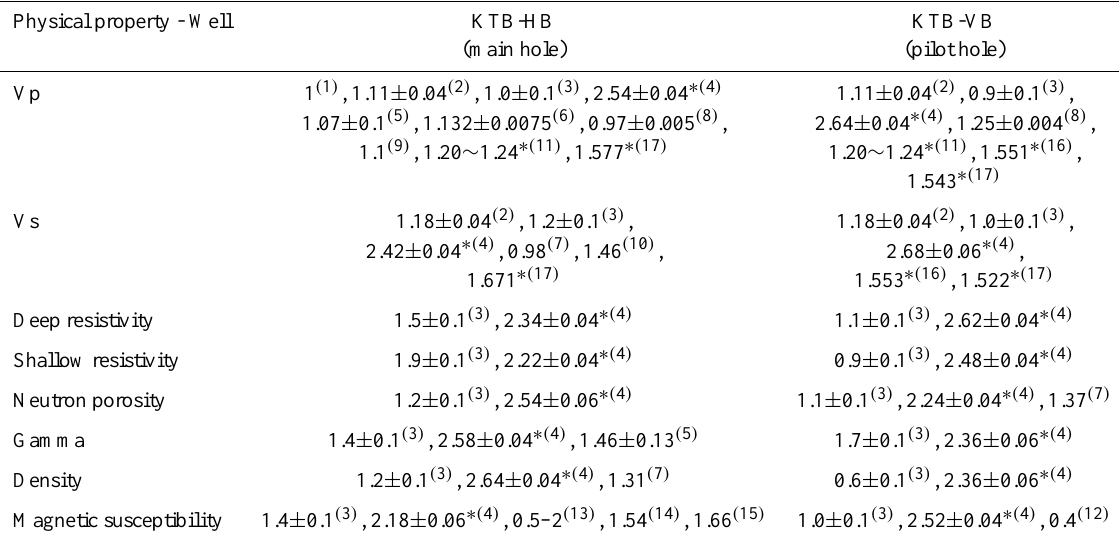
Table 5. Spectral exponents for the KTB physical logs obtained from previous works.